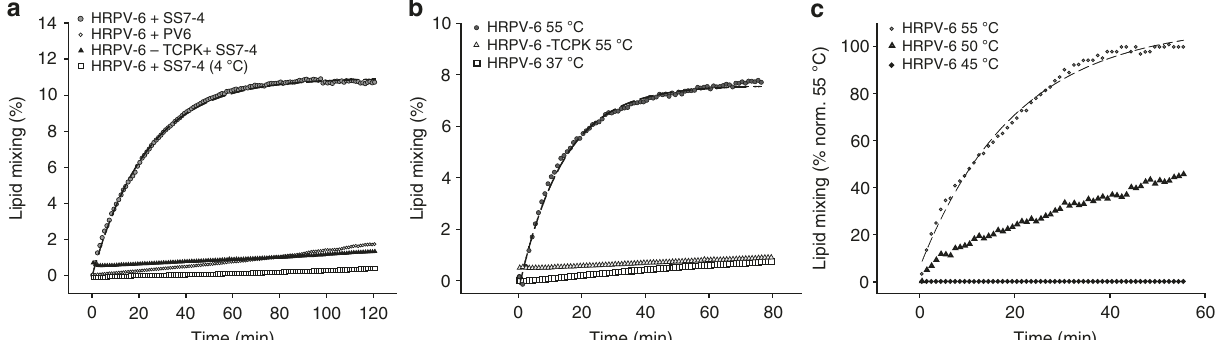
Fig. 5 Halorubrum virus membrane fusion. a HPRV-6 fusion kinetics with cells. Fluorescently labelled HRPV-6 was incubated at 37 °C with Halorubrum sp. SS7-4 host cells (grey dots) or the non-host cells Halorubrum PV6 (white dots) at 37 °C under continuous stirring and dequenching measured at 585 nm. As additional controls, HPRV-6 was incubated with Halorubrum sp. SS7-4 host cells at 4 °C (white boxes) or spikeless HRPV-6 was prepared by proteinase K digestion (TCPK) and incubated with the same host cells at 37 °C (black triangles). b HPRV-6 fusion kinetics with liposomes derived from haloarchael SS7-4 cell lipids. Fluorescently labelled HRPV-6 was incubated with liposomes at 37 °C (white boxes) and 55 °C (grey dots). As a control, spikeless HRPV- 6 was incubated with haloarchaeal liposomes at 55 °C (white triangles). Results from A and B are representative for n = 3 independent experiments. c Lipid mixing kinetics of fl uorescently labelled HRPV-6 particles after incubation with liposomes at 45 °C (black dots), 50 °C (white triangles) and 55 °C (grey dots) normalized to the maximum extend of fusion at 55 °C. Each segmented line represent the single exponential fi t to the kinetic data. Source data are provided as a Source Data fi